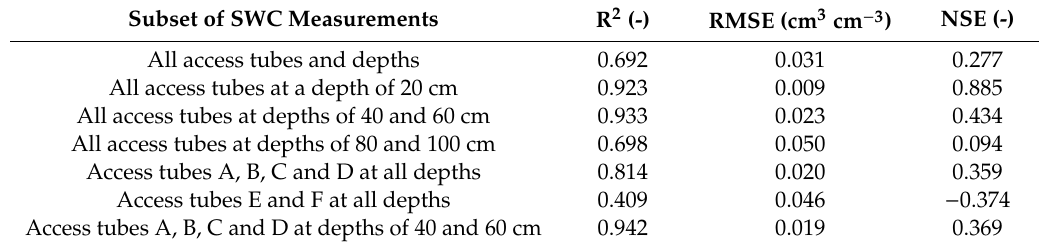
Table 5. Summary of the fit between soil water content (cm 3 cm − 3 ) measured by neutron probe in 2018 and HYDRUS-3D simulations using soil hydraulic parameters obtained from HYPROP + WP4C.